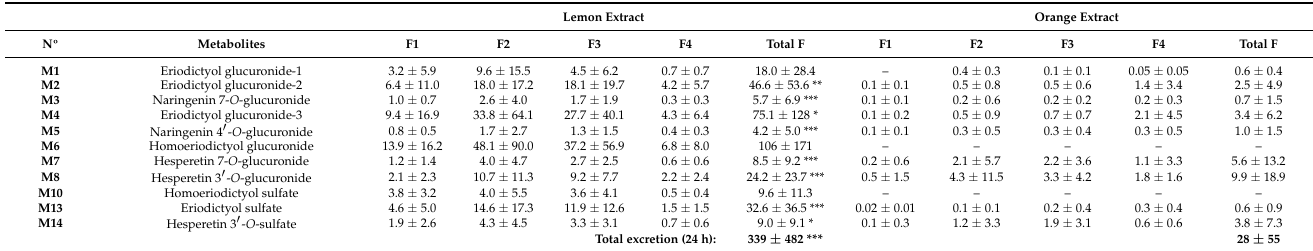
Table 4. Metabolites quantified in urine fractions (Figure 1) after consuming lemon or orange extract. LemonExtract